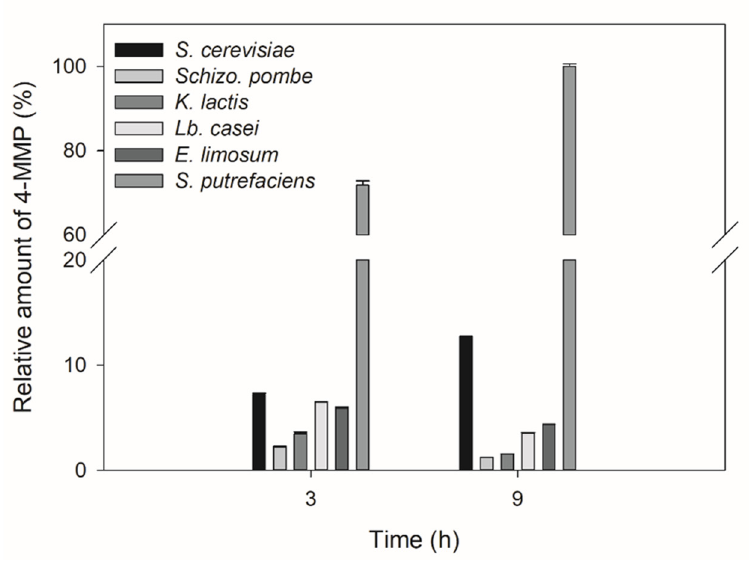
Figure 6. The relative production of 4MMP from Cys-4MMP by microbial cell